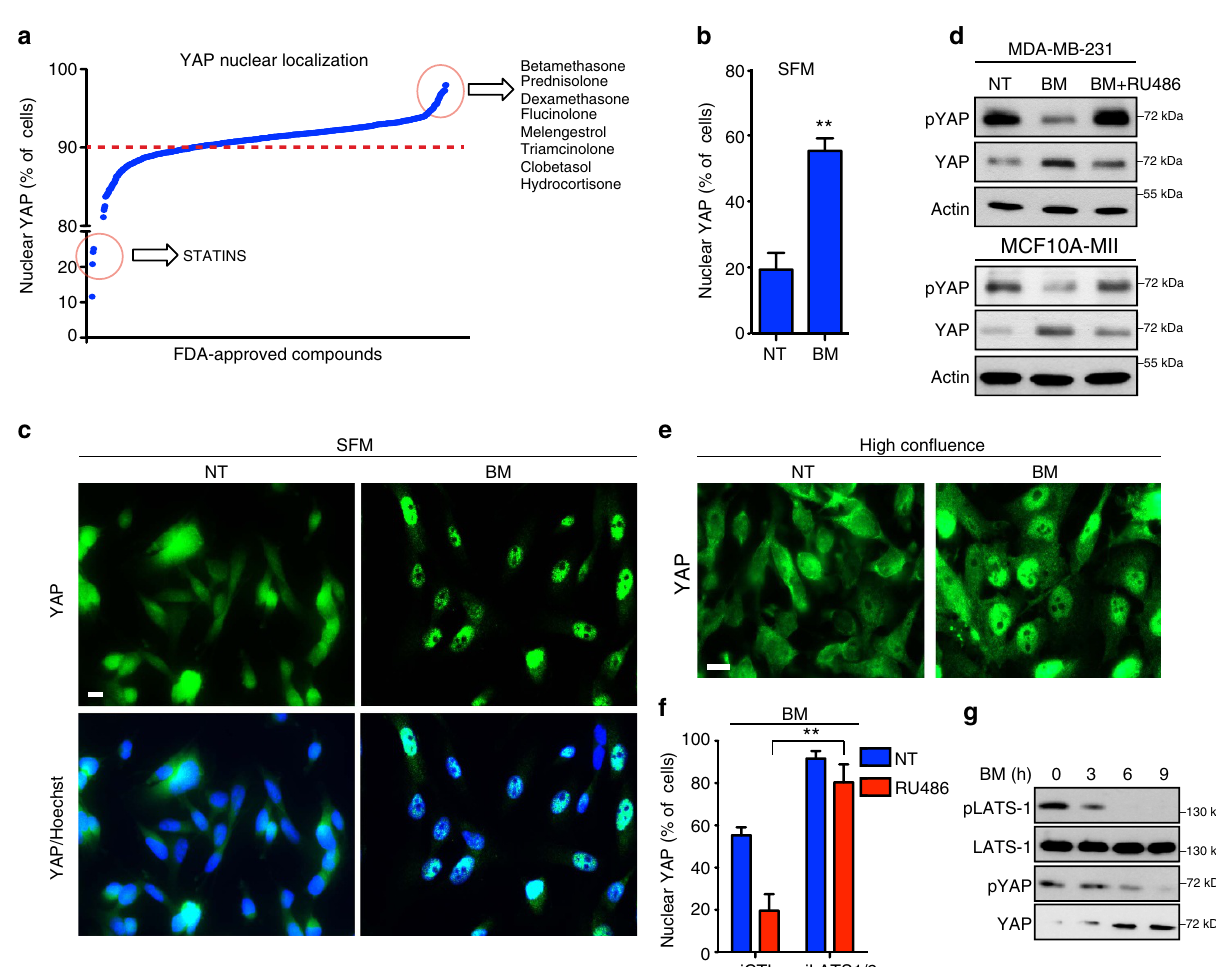
Figure 3 | Glucocorticoids induce YAP nuclear localization. ( a ) Results of the high-content screening. ( b ) Quantification of MDA-MB-231 cells with nuclear YAP by immunofluorescence. Cells were grown in serum-free medium (SFM) and treated with betamethasone (BM) 0.1 m M for 24h. Error bars represent mean ± s.d., from n ¼ 3 biological replicates. ( c ) Cells were treated as in b . Representative images are shown. Scale bars, 15 m m. ( d ) MDA-MB-231 and MII cells were grown in SFM and treated with BM 1 m M alone or in combination with RU486 1 m M for 24h. Representative blots are shown. pYAP is phospho-Ser127. Experiment repeated three times. ( e ) MDA-MB-231 cells were grown at high confluence and treated with BM 1 m M for 24h. Representative images are shown. Experiment repeated three times. Scale bars, 15 m m. ( f ) Quantification of cells with nuclear YAP by immunofluorescence. MDA-MB-231 cells were transfected with indicated siRNAs for 24h and treated with RU486 1 m M for additional 24h in SFM containing BM 1 m M. Error bars represent mean ± s.d., from n ¼ 3 biological replicates. ( g ) MDA-MB-231 cells were serum starved and treated with BM 1 m M for indicated times. Representative blots are shown. * P o 0.05, ** P o 0.01; two-tailed Student’s t -test is used